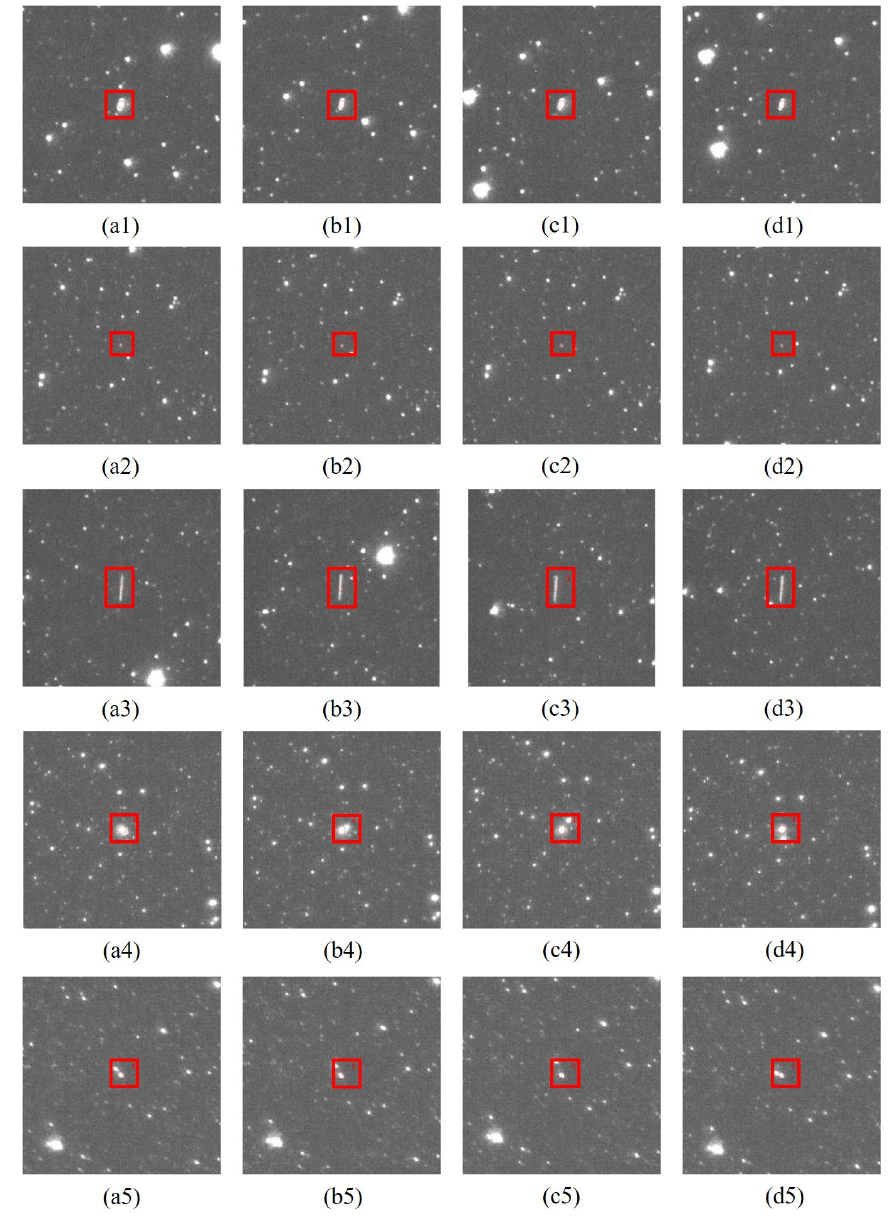
Figure 6. Original targets in sequences. ( a1 – d1 ) Target 1. ( a2 – d2 ) Target 2. ( a3 – d3 ) Target 3. ( a4 – d4 ) Target 4. ( a5 – d5 ) Target